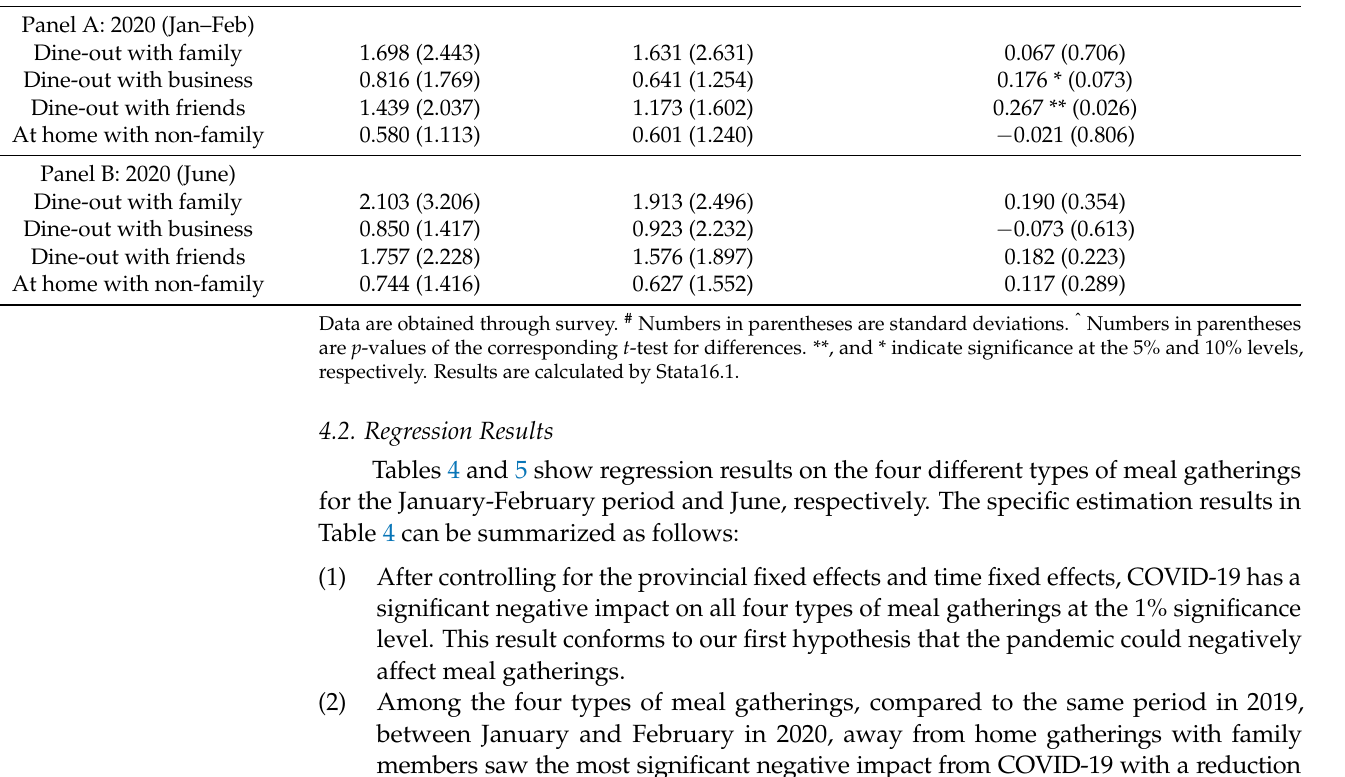
Table 3. Meal Gatherings in Epicenters and Non-Epicenters of the Pandemic (Frequencies). (1) Epicenter # (2) Non-Epicenter # (3) Difference (Epicenter–Non-Epicenter)